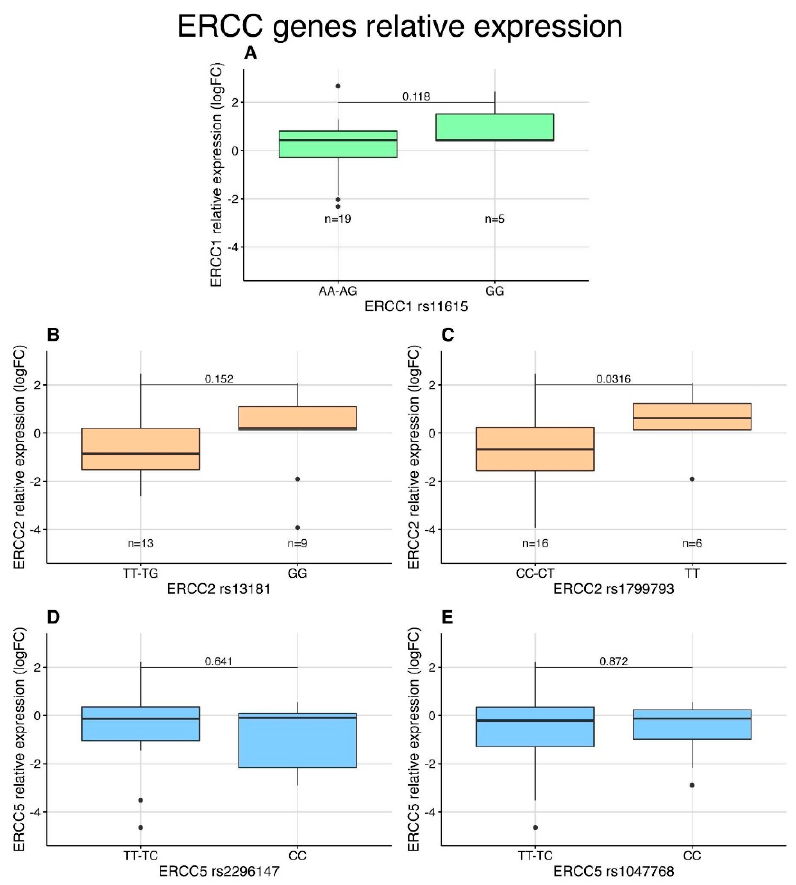
Figure 5. Correlation analysis between relative gene expression and genotype in 5 different SNPs ( A ) ERCC1_rs11615, ( B ) ERCC2_rs13181, ( C ) ERCC2_rs1799793, ( D ) ERCC5_rs2296147, ( E ) ERCC_rs1047768. The relative gene expression is presented as log2 Fold Change. In every plot, the samples were separated according to the presence (left side) or absence (right side) of at least one wild-type allele. The significance value at the top of every plot was obtained via Welch’s t -test. FC, fold change.